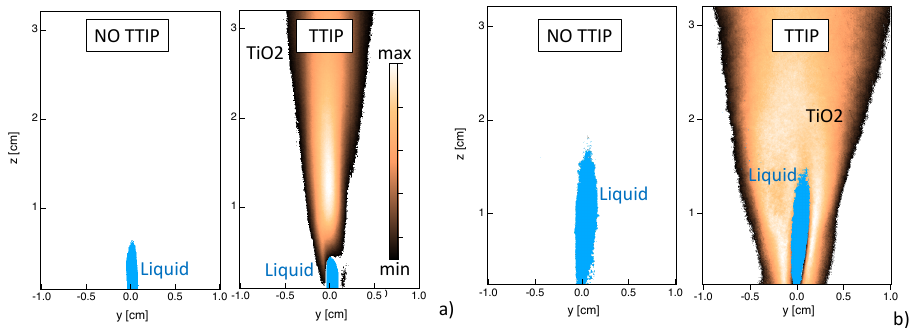
Figure 4. Localization of liquid phase (blue color) and TiO 2 nanoparticles (brown palette) via ( a ) shadowgraphy, and ( b ) light scattering. Time-averaged results (left) without and (right) with injection of TTIP are